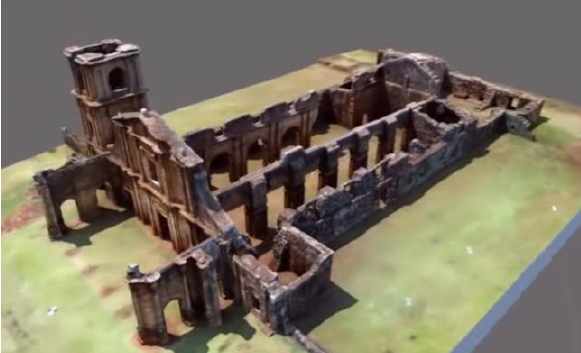
Figure 12 – Fusion of 3D models produced by Photogrammetry and